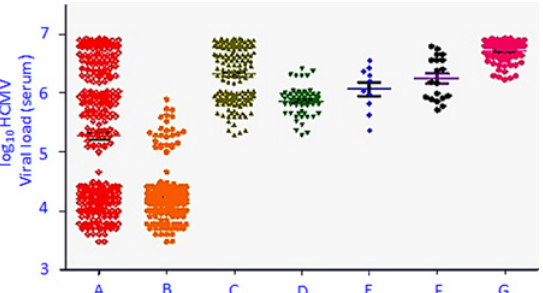
Fig 2. Serum CMV viral load amongst the subjects with varying manifestations. A: All CMV positive subjects (n = 337). B: CMV positive subjects with no CMV associated end-organ diseases (n = 175). C: Subjects with HCMV EODs (n = 162). D: Subjects with HCMV retinitis (n = 58). E: Subjects with HCMV pulmonary diseases (n = 10). F: Subjects with HCMV GIT diseases (n = 19). G: Subjects with disseminated HCMV diseases (n = 75).